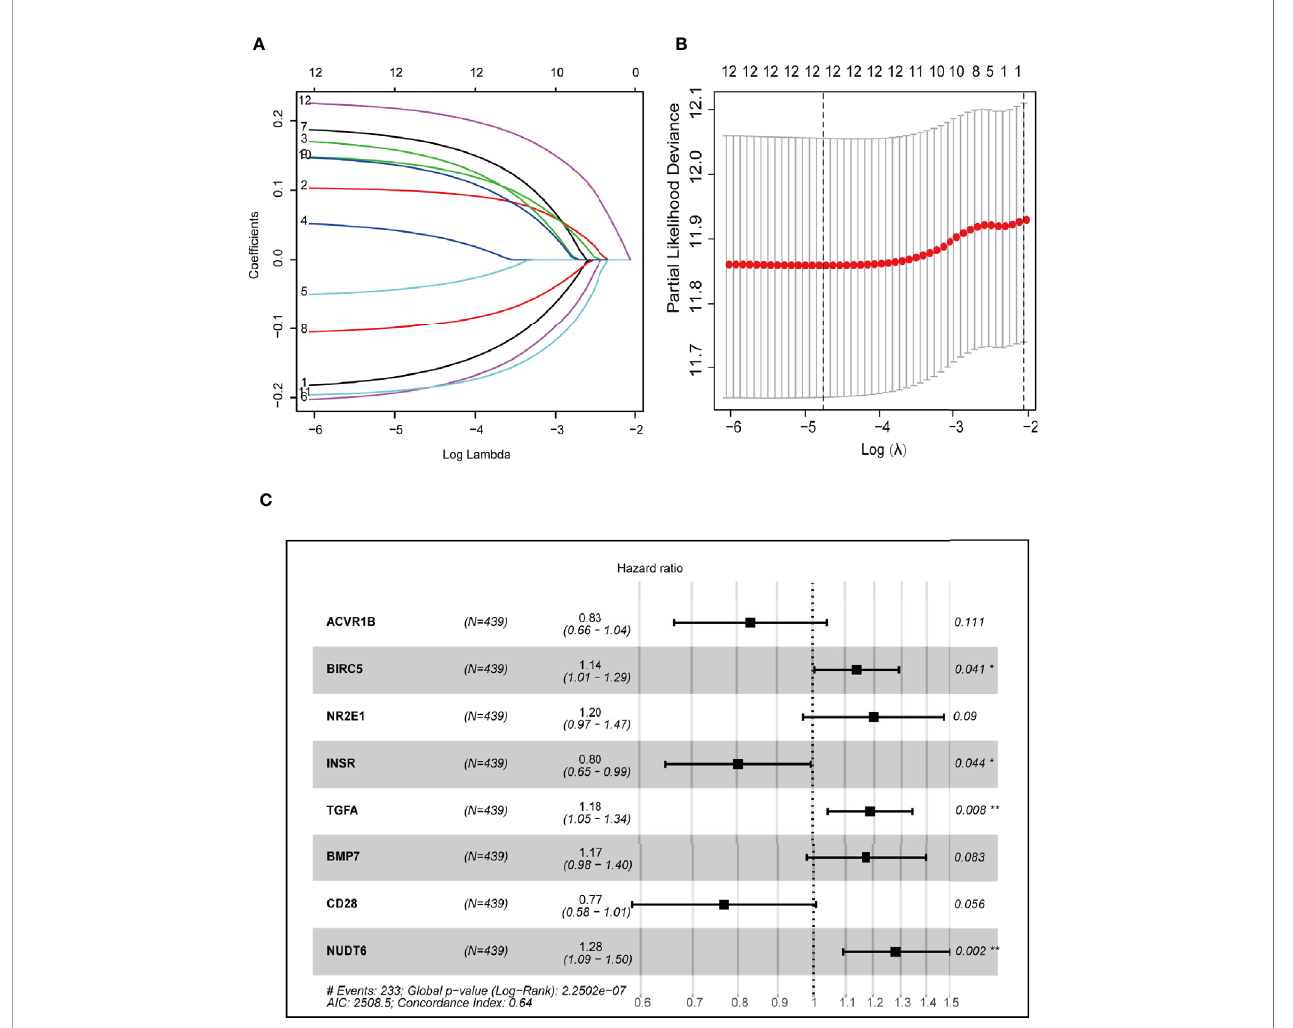
FIGURE 3 | Construction of prognostic models based on CCRGs and IRGs. (A, B) LASSO Cox regression analysis based on OS. (C) Forest plots presenting the multivariate Cox proportional hazards regression analysis of prognostic CCRGs and IRGs in